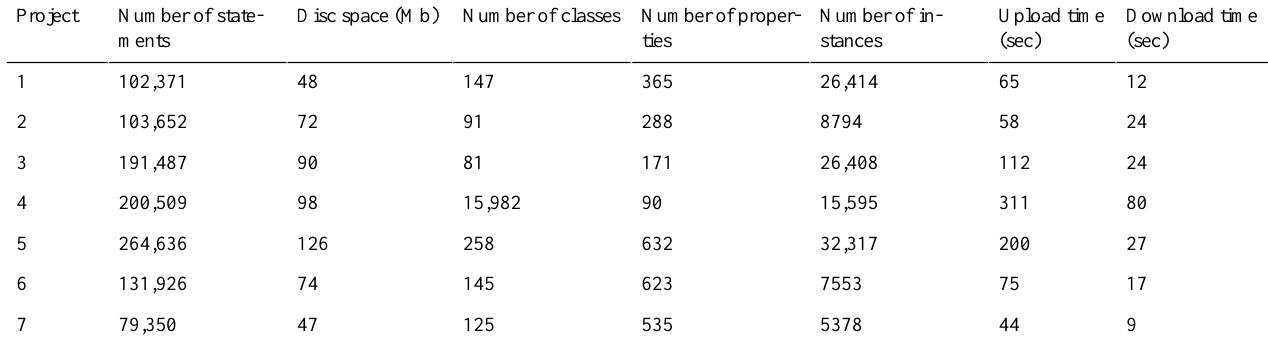
Table 1. Summary of characteristics of the projects